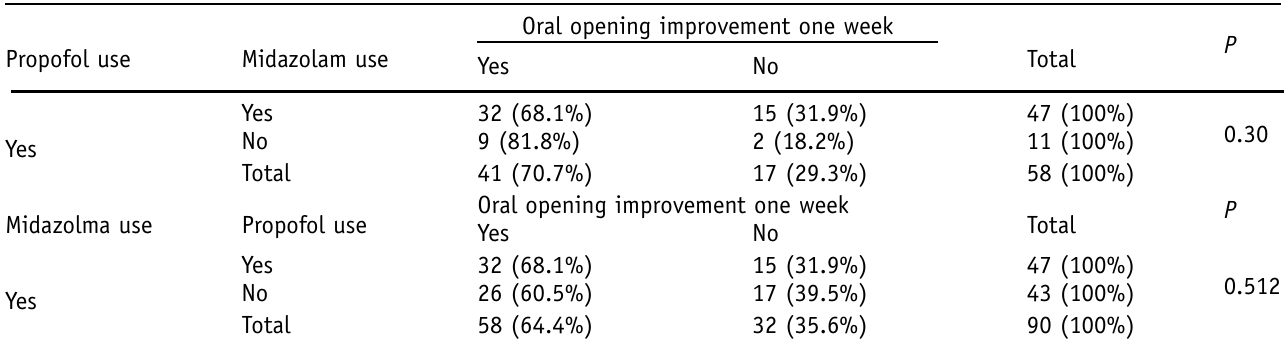
Table III. Relationship between improvement in oral opening and the use of propofol with or without midazolam and the use of midazolam with or without propofol during sedation at one week